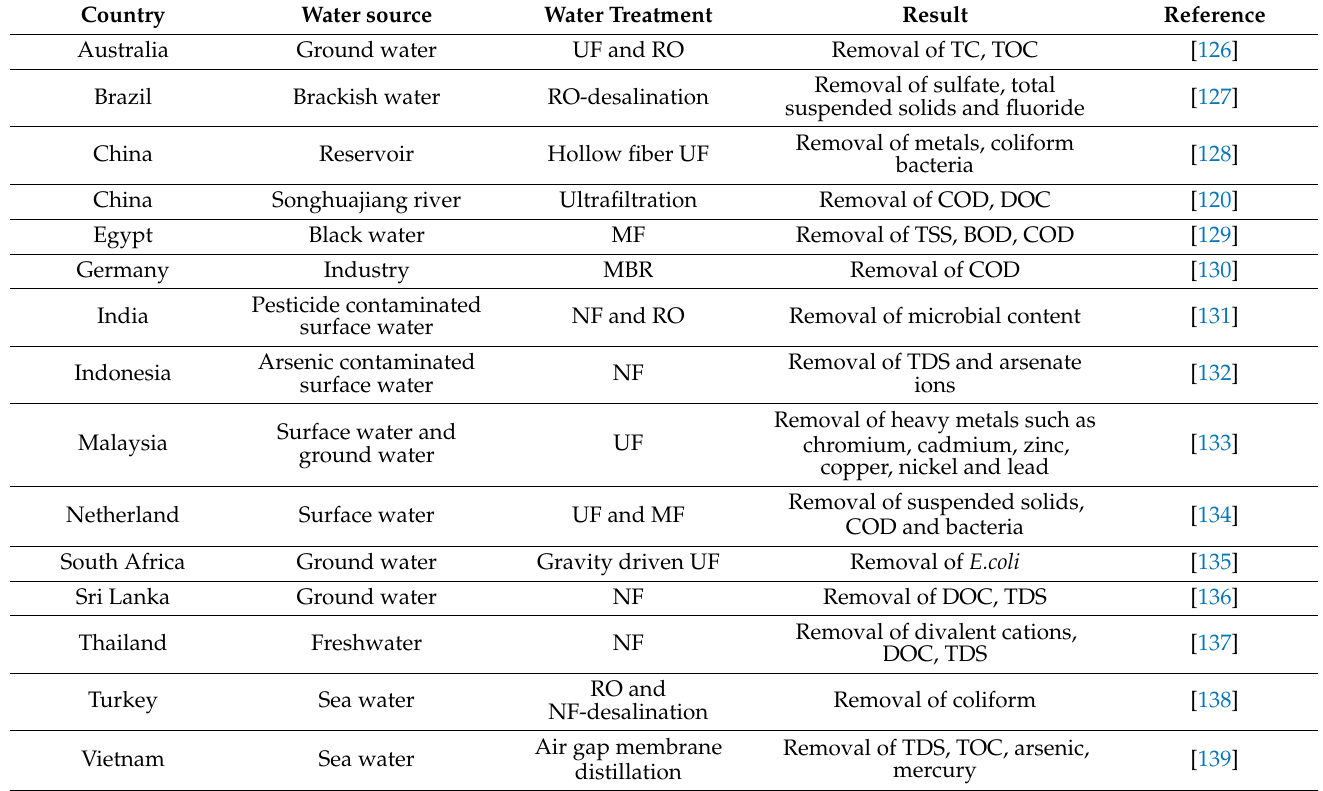
Table 8. Water treatment usage in different